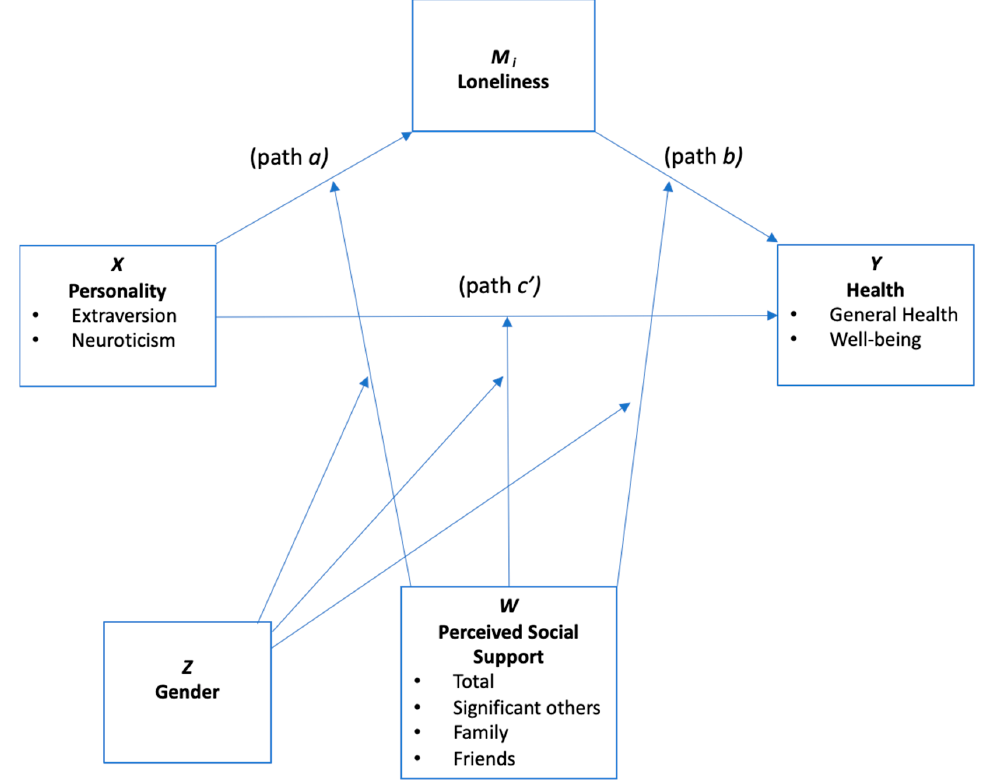
Figure 1. Conceptual moderated mediation model showing effects of personality on health via loneliness. Indirect effect of loneliness (mediator) by perceived social support (moderator) and gender (moderator) conceptualised to carry the effect of personality on health.